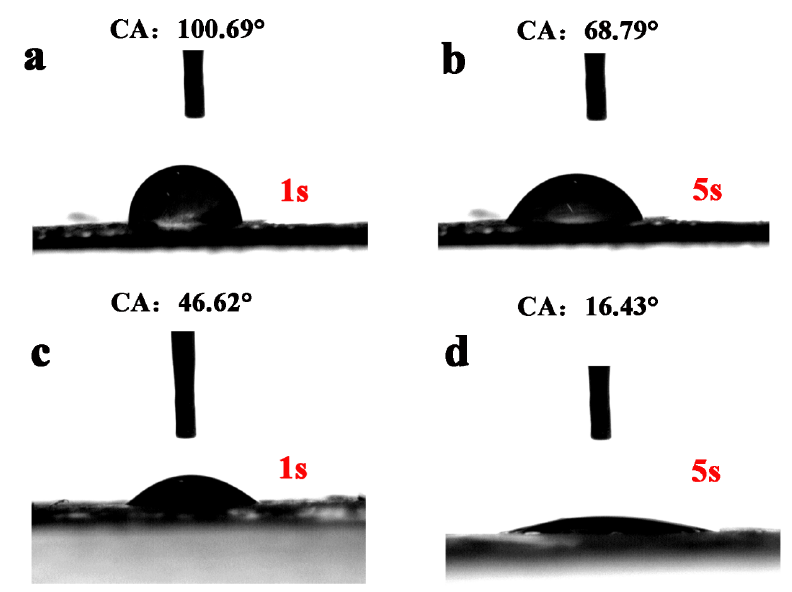
Figure 3. The contact angle of ( a ) NiCoAl-LDH at 1s, ( b ) NiCoAl-LDH at 5s, ( c ) NiCoAl-OH at 1s, and ( d ) NiCoAl-OH at 5s.